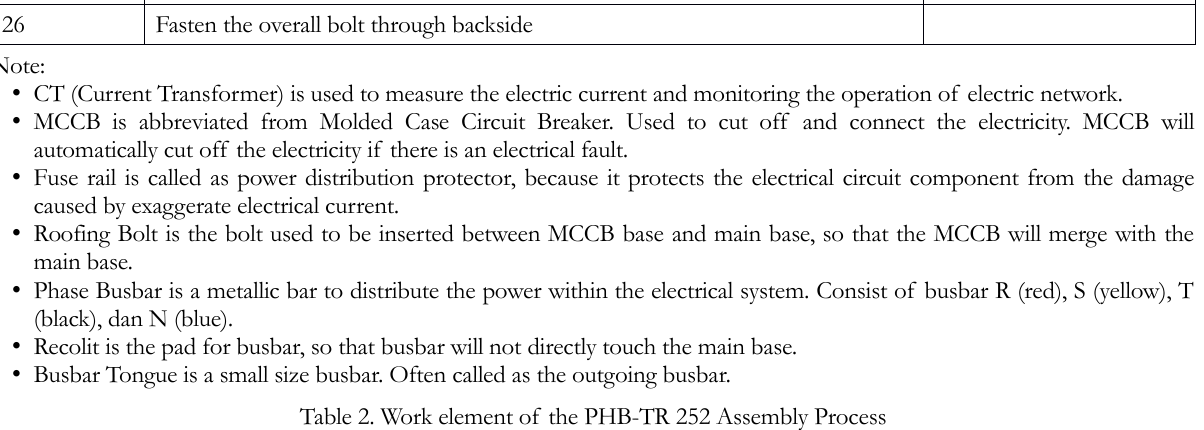
Table 2. Work element of the PHB-TR 252 Assembly